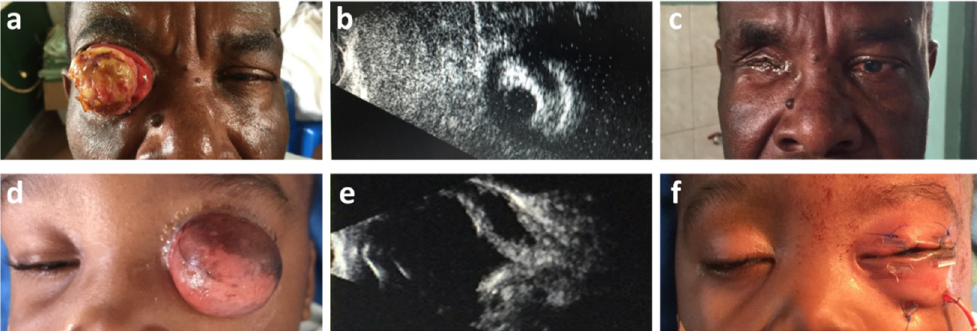
Figure 2. Ocular adnexal pathology. ( a ) Large carcinoma of the conjunctiva, tumor not appearing to be invading the lid margins. ( b ) B-scan ultrasound displaying a solid mass in front of the anterior segment of the eye. Sagittal section through the anterior segment of the eye displays an iris structure with a light-sensitive pupil. ( c ) Postoperative results 16 months after lid skin-saving extended enucleation and a total permanent tarsorrhaphy. ( d ) Fourteen-month-old child with a uni-